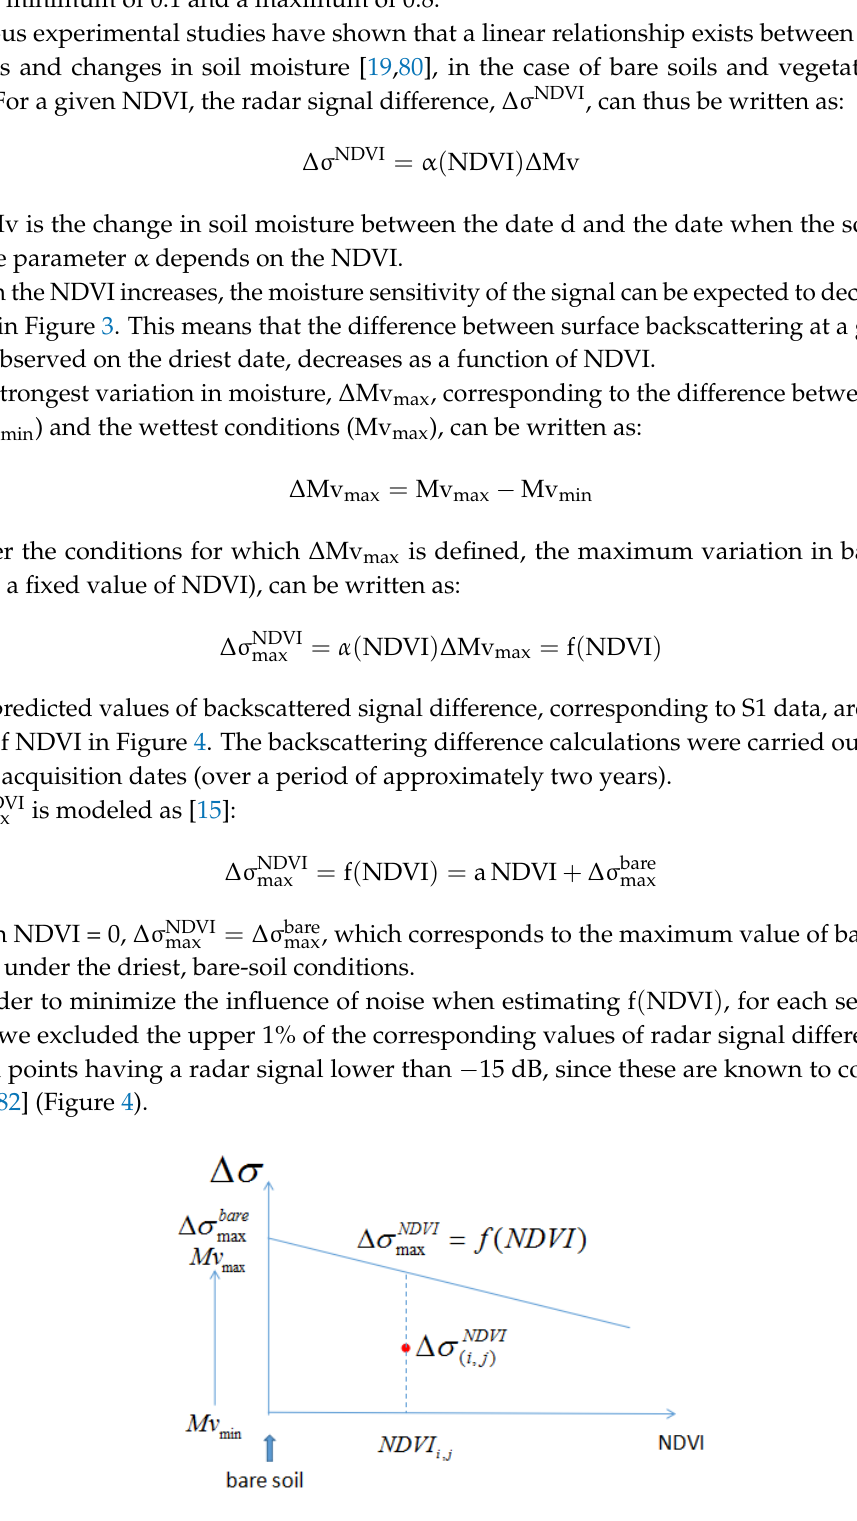
Figure 3. Illustration of the relationship between NDVI and Mv used in method